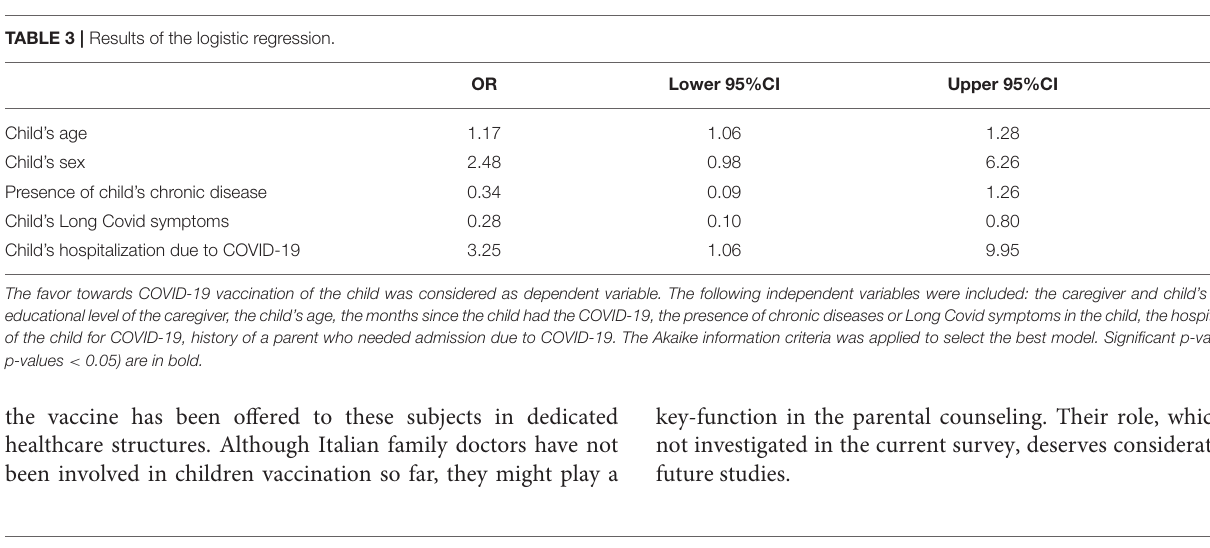
In favor Others